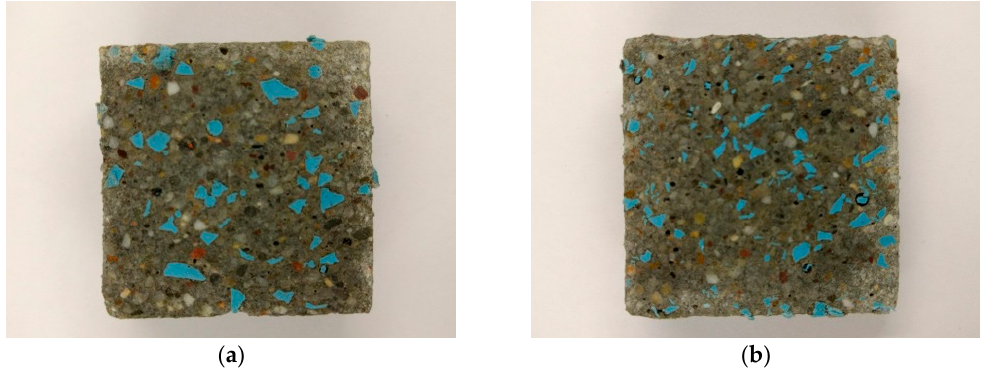
Figure 3. Images of the cross section of mortar specimen with WSRPs embedded ( a ) L series (particle size: 2–4 mm); ( b ) M series (particle size: 1–2 mm). The length of scale bar in images is 10 mm.